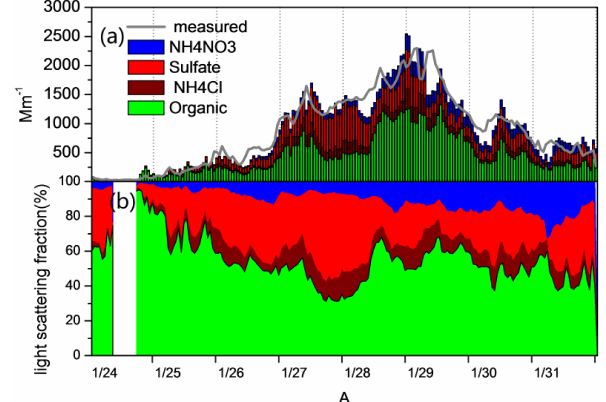
Figure 10. Lleft panel: the frequency distribution of m / z 44; top panel: the frequency distribution of organic mass; center panel: abundance of m / z 44 as a function of organic aerosol mass con- centration and the influence of RH (left, color scale).